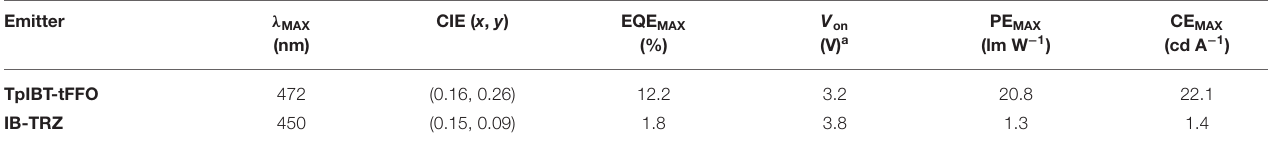
TABLE 5 | OLED performances of TpIBT-tFFO and